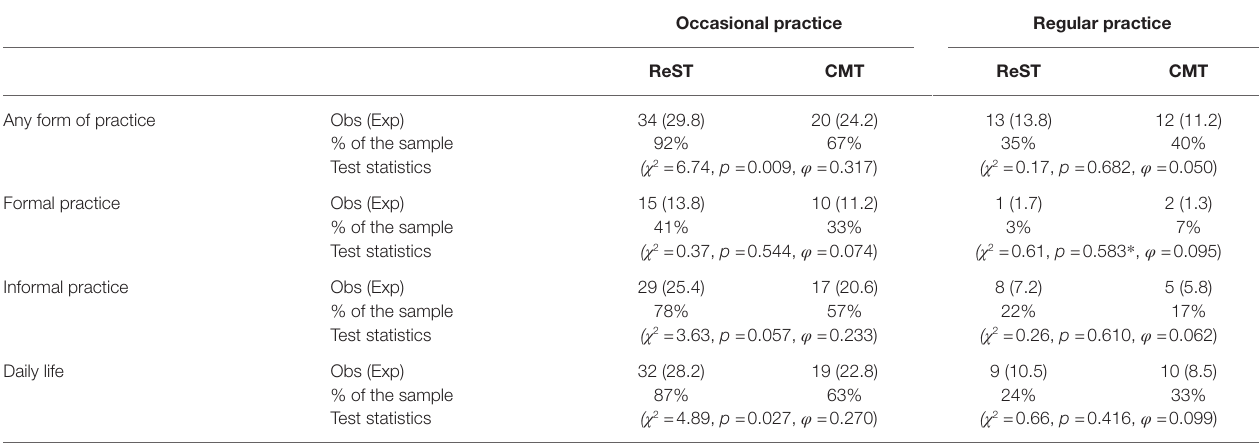
TABLE 2 | Observed and expected numbers and percentages of participants in restoration skills training (ReST) and conventional mindfulness training (CMT) courses who 6 months after the course indicated that they had continued to practice mindfulness occasionally (i.e., at least several times) since the course ended and regularly (i.e., at least once per